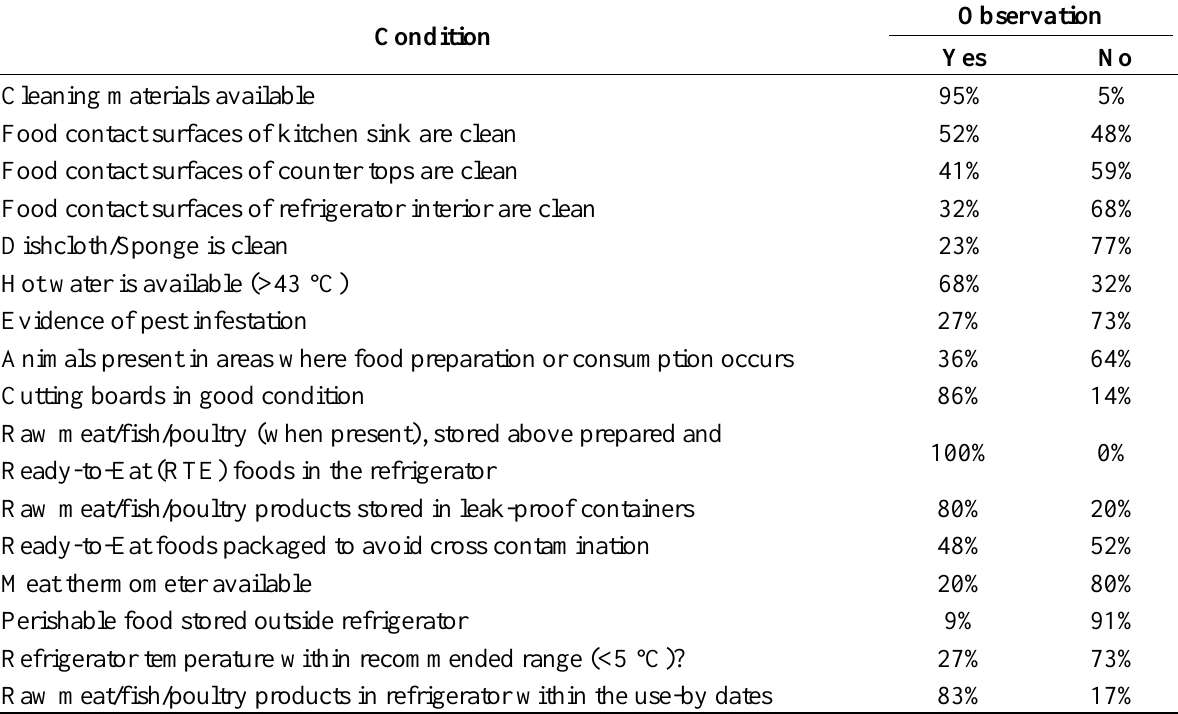
Table 2. Prevalence of unsafe food handling or storage conditions observed during pilot study.